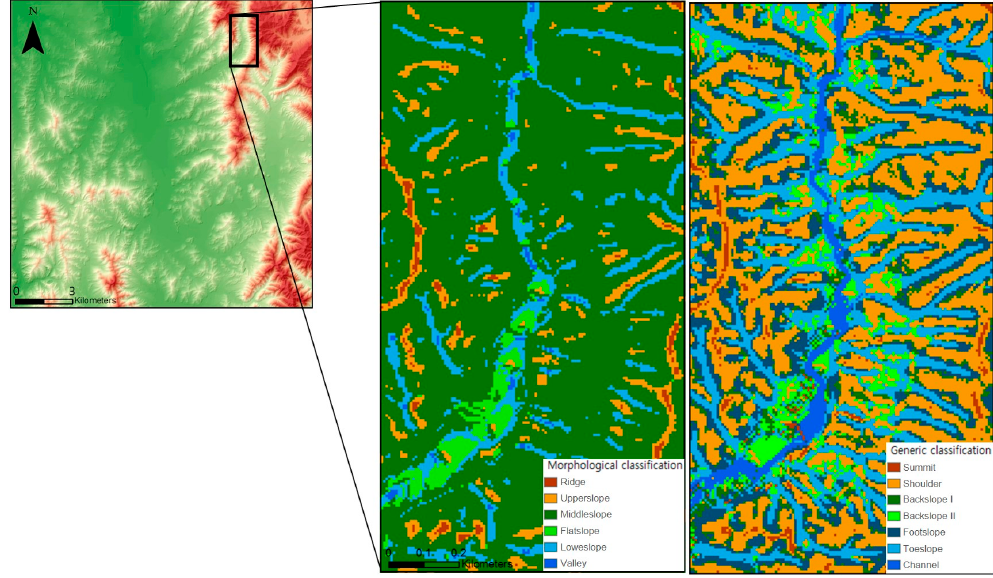
Figure 4. Topographic class maps by generic and morphometric topographic classifications (Cheongju).